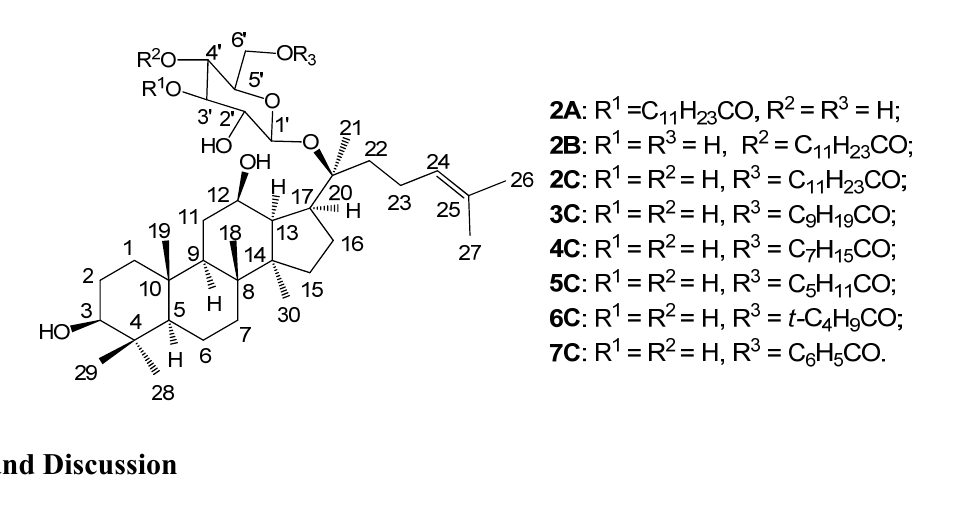
Figure 2. The structures of M1 esters 2 – 7